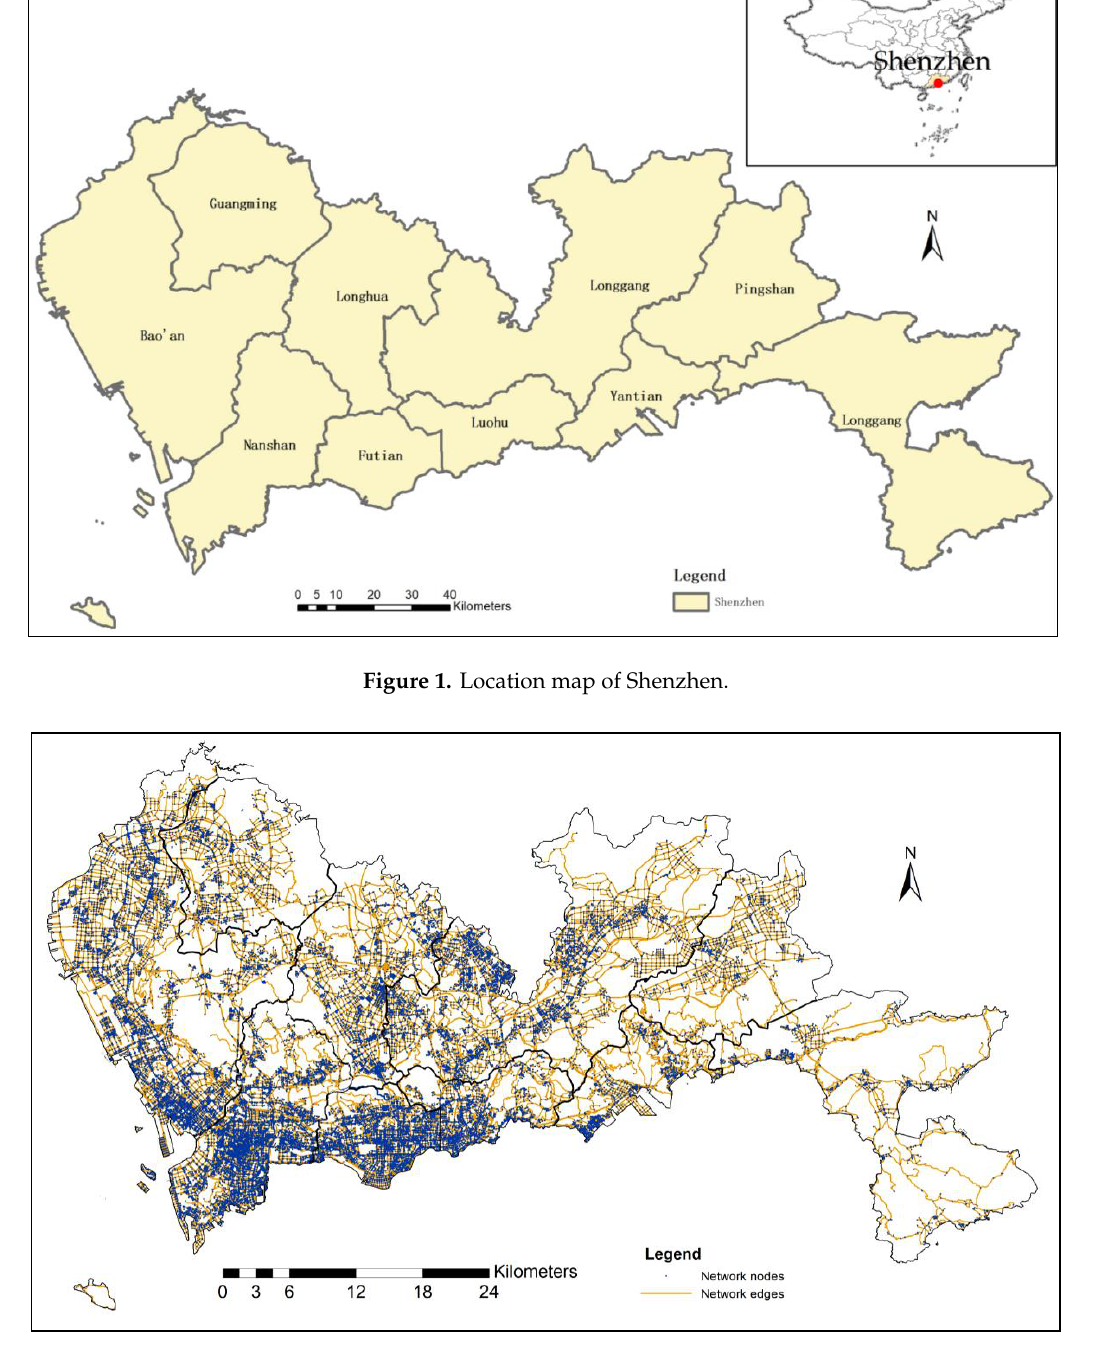
Figure 2. Digital representation of road network in Shenzhen.